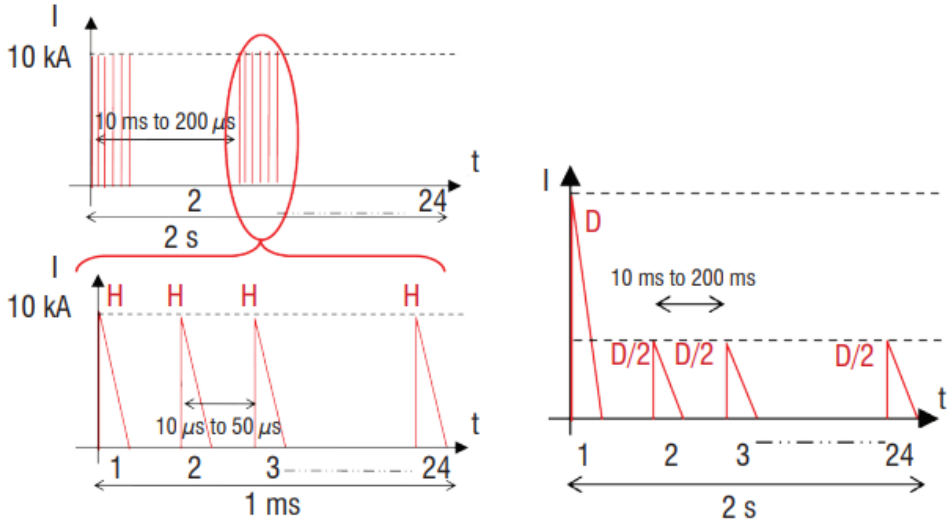
Figure 3. Repetitive current pulses used to test the immunity of avionics, according to the DO-160 aviation standard [9,18].